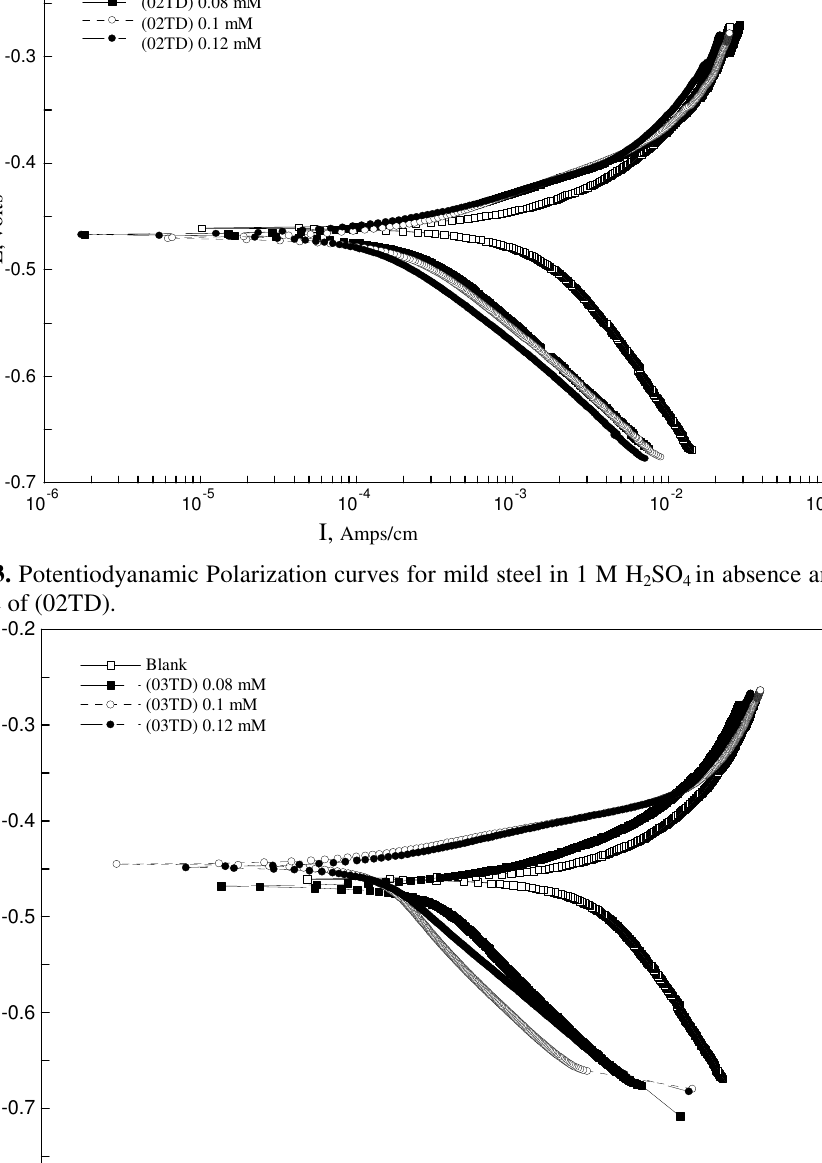
Figure 4 . Potentiodyanamic Polarization curves for mild steel in 1 M H presence of